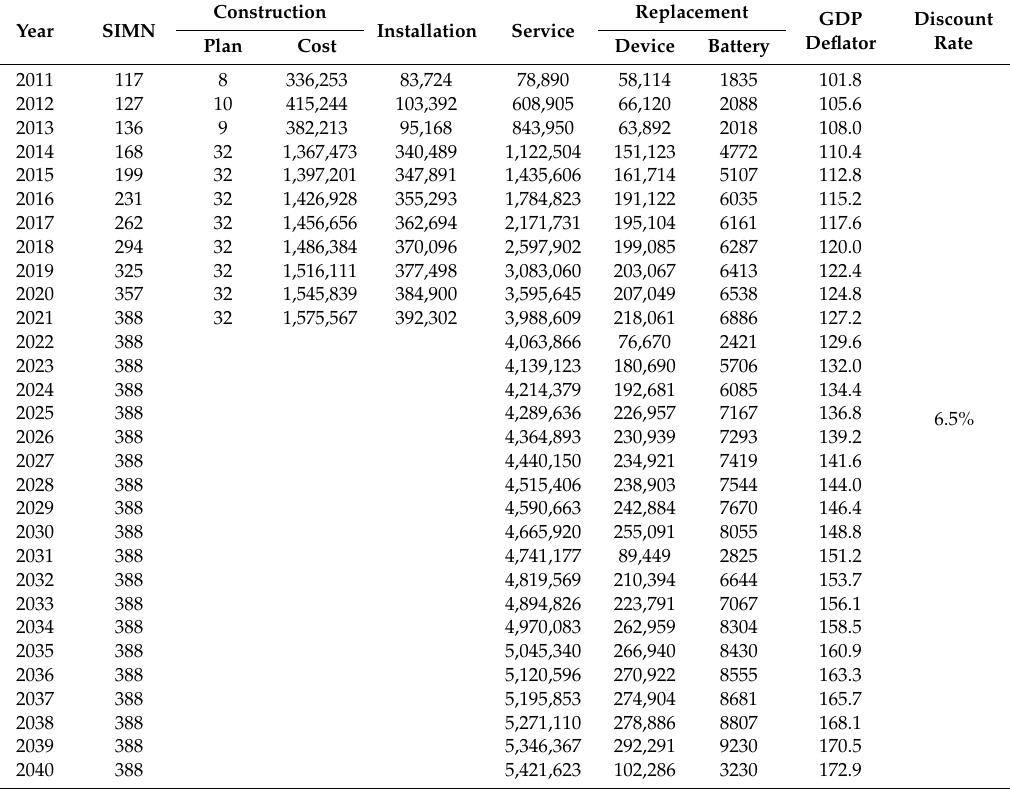
Table A4. Cost detail of the SIMN (unit: